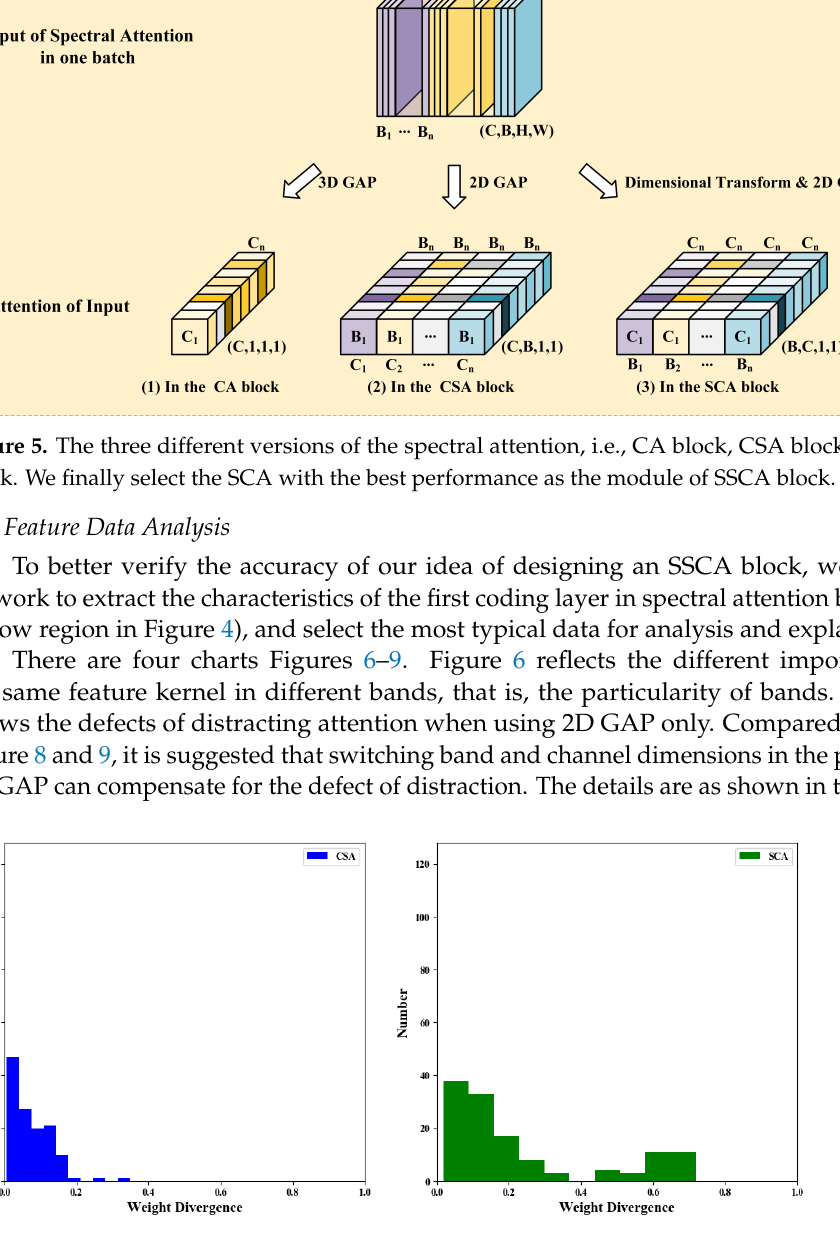
Figure 6. The bar chart of kernel weight divergence between different bands of CSA and SCA. The horizontal axis Weight Divergence indicates max ( B C i n ) − min ( B C i n ) , and the vertical axis Number indicates the number of weight